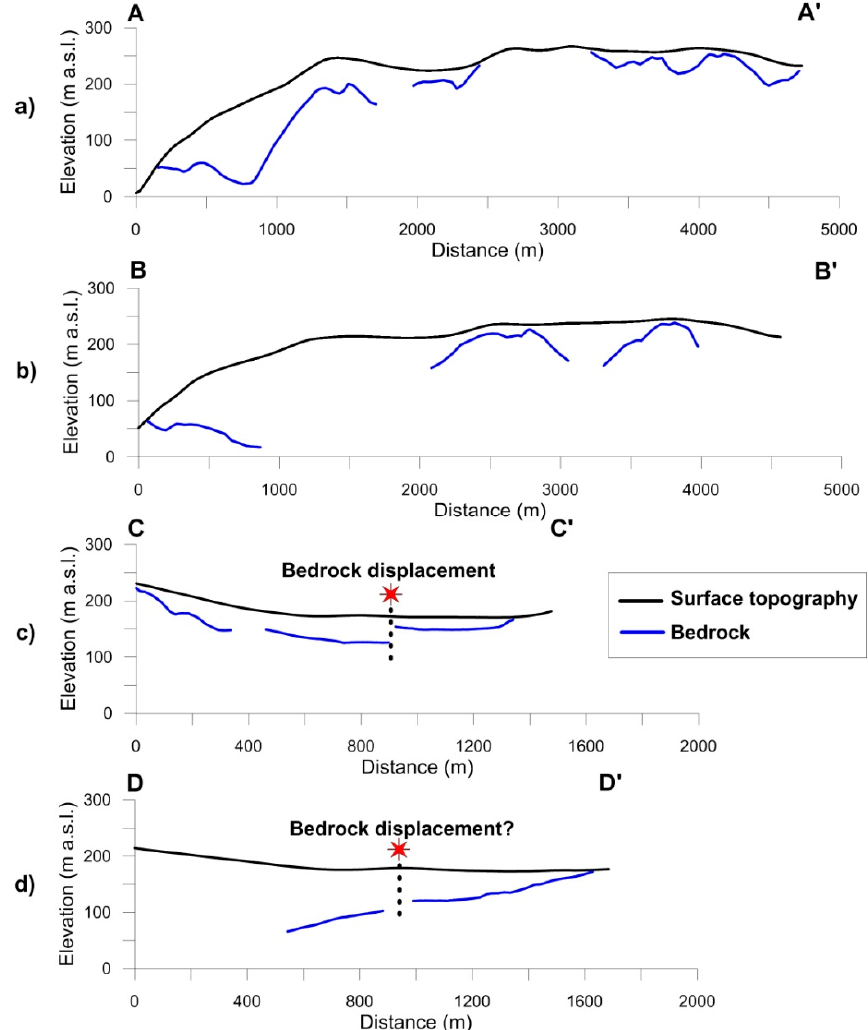
Figure 8. Bedrock elevation picked along radargrams (airborne 40 MHz): ( a ) section AA’ (vertical exaggeration: 4); ( b ) section BB’ (vertical exaggeration: 4); ( c ) section CC’ (vertical exaggeration: 2); ( d ) section DD’ (vertical exaggeration: 2).